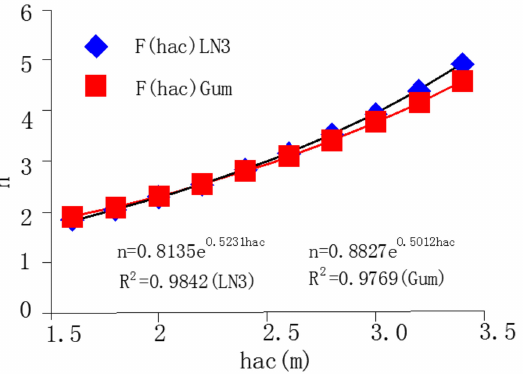
Figure 5. Fitting results between waiting weather window duration and threshold heights h ac .